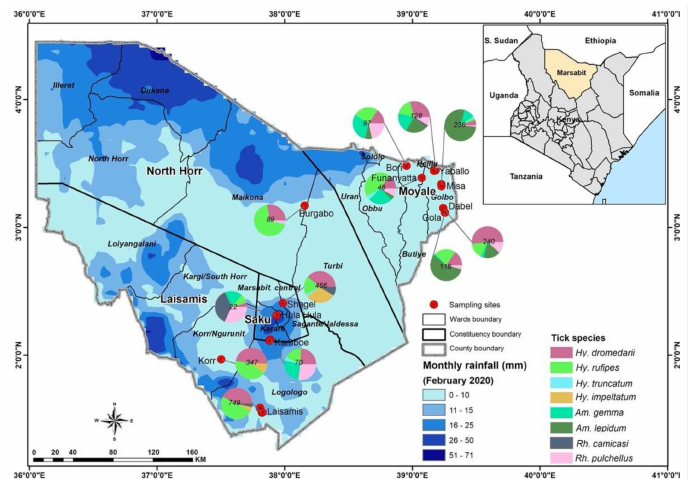
Figure 1. Sampling sites in Marsabit County, Kenya, showing the spatial distribution of tick species collected from camels and co-grazing sheep. Maps were created using the open-source software, QGIS v.3.10.6. Pie charts indicate numbers of ticks collected at sampling